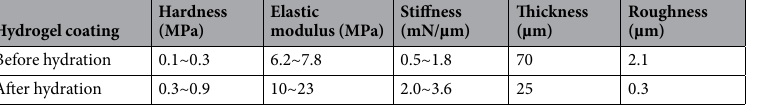
Table 1. Hardness, elastic modulus, stiffness, thickness and surface roughness of the hydrogel coating specimen before and after